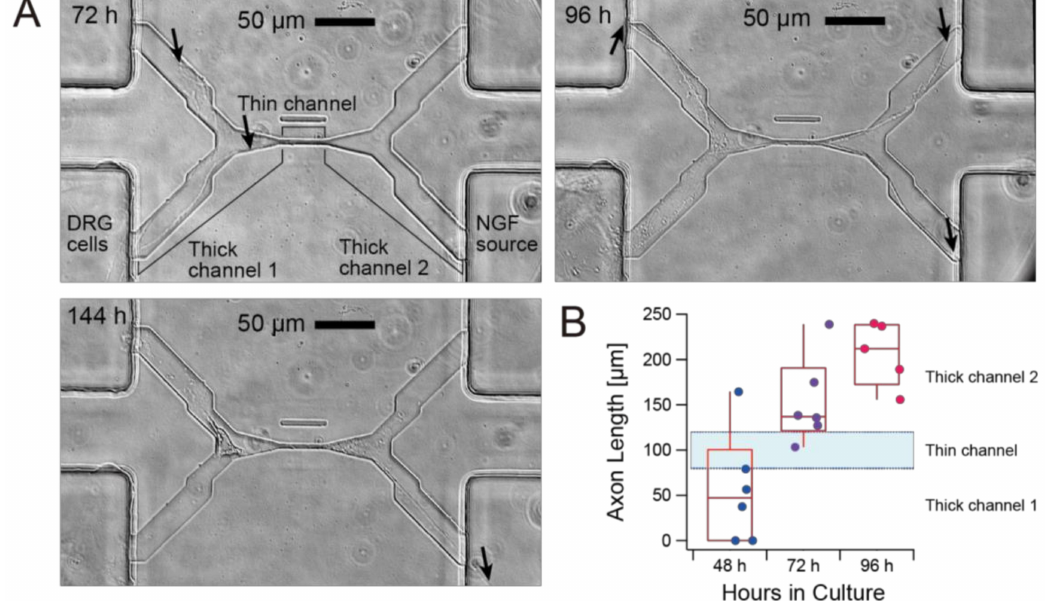
Figure 5. Axon elongation of primary nerve (dorsal root ganglion: DRG) cells from chick embryo in culture on the microfluidic chip. ( A ) Phase contrast images of axon elongation from the inlet of the cell channel ( bottom left ), the thick channel 1, the thin channel, the thick channel 2, and the source of nerve growth factor (NGF) ( bottom right ). Arrows denote the tip of an outgrowth axon. ( B ) Time evolution of the length of axons cultured on six different chips from the same mold. Dots above the “Thin Channel” band indicate that the axons passed through the thin channel, meaning that the axon is chemically separated from the cell